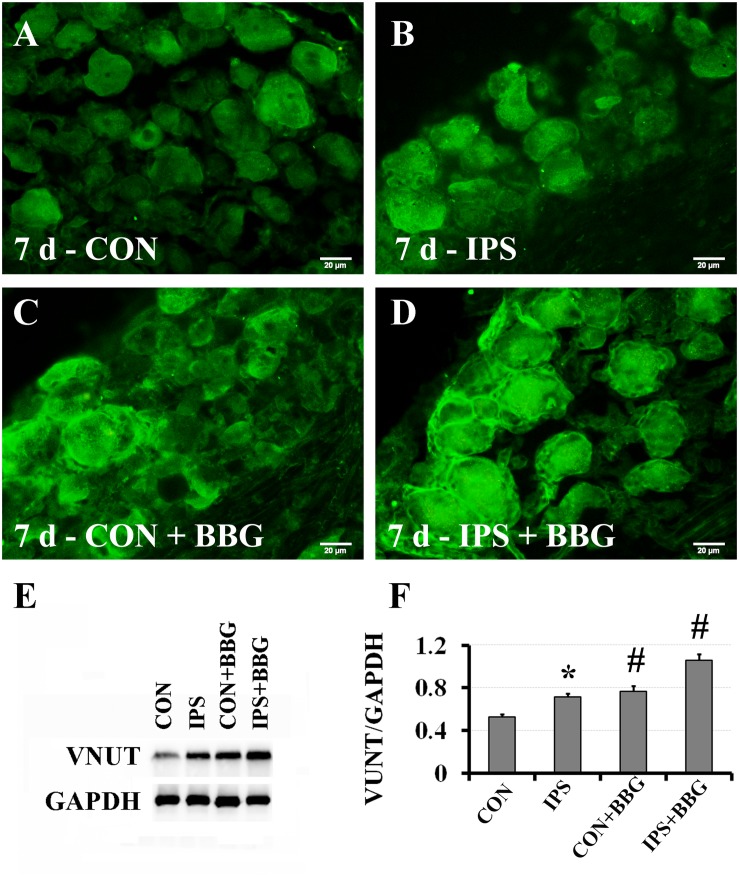
Upregulation of VNUT expression after inhibition of the P2X7 receptor with BBG. After right sciatic nerve crush, BBG (P2X7 receptor inhibitor) was injected intraperitoneally. VNUT immunofluorescence in DRG was detected on the 7th day. (A–D) VNUT immunofluorescence staining (green), scale bar = 20 μm. (E) The level of VNUT protein was detected by western blotting (N = 3). The level of GAPDH was detected as loading control. (F) The expression of VNUT before and after BBG treatment on the 7th day after SNC was analyzed with the paired t-test, “∗” compared with the control side, P < 0.001; “#” compared with the contralateral side and the ipsilateral side before BBG treatment, P < 0.001. CON: contralateral DRG, IPS: ipsilateral DRG.